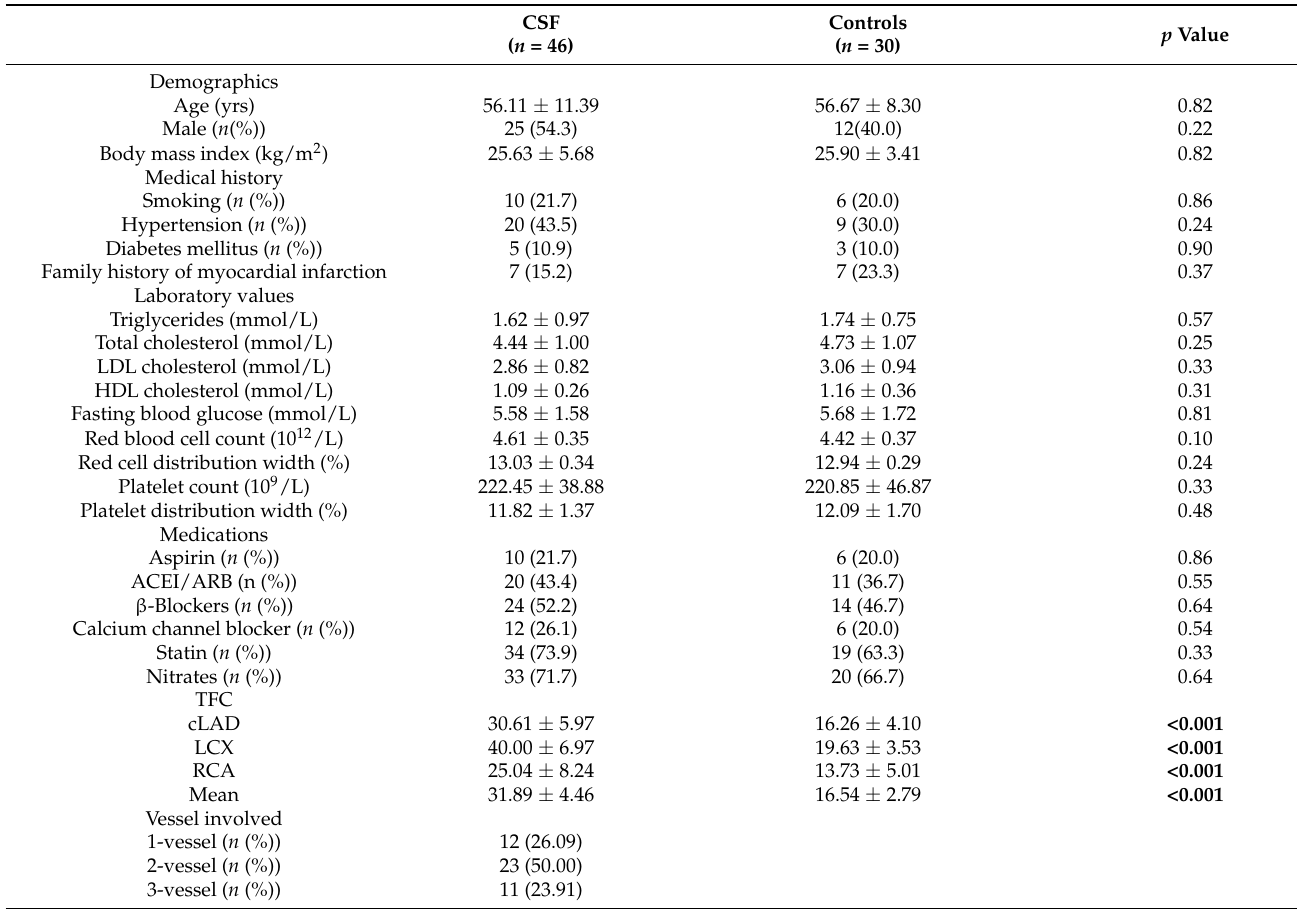
Table 1. Comparison of baseline clinical characteristics and angiographic